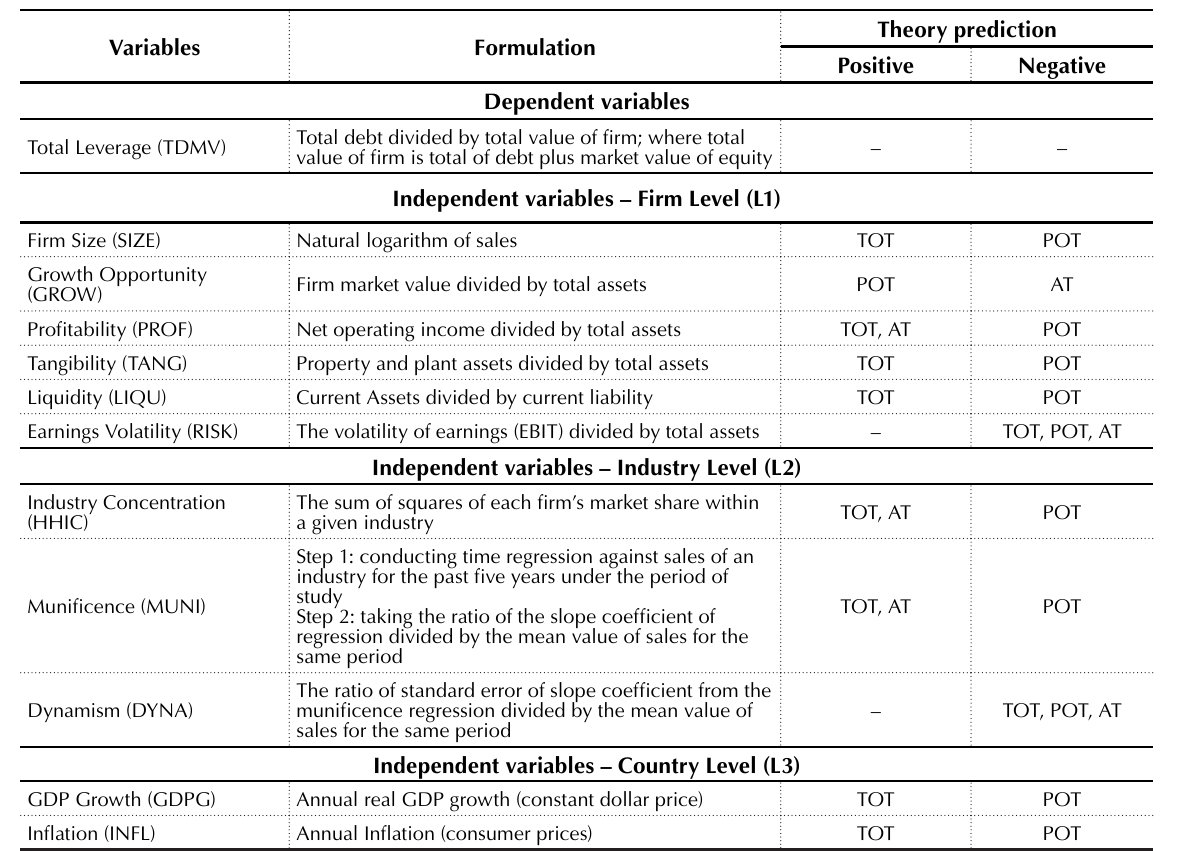
Table 1. Variable definition and theory